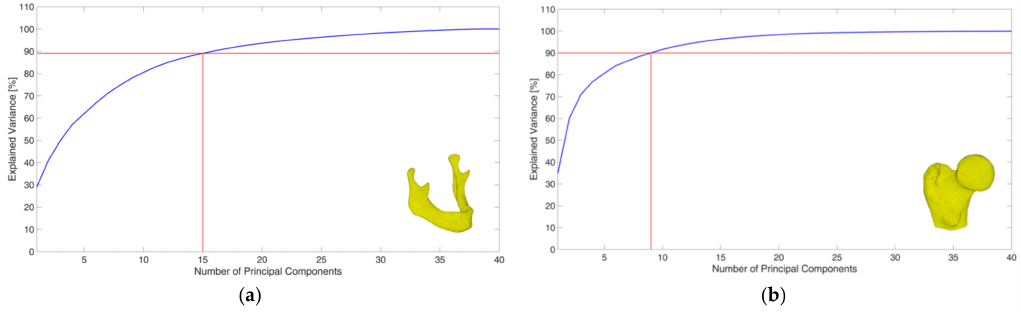
Figure 2. Cumulative explained variance versus the number of principal components for the mandible ( a ) and for the proximal femur ( b ).